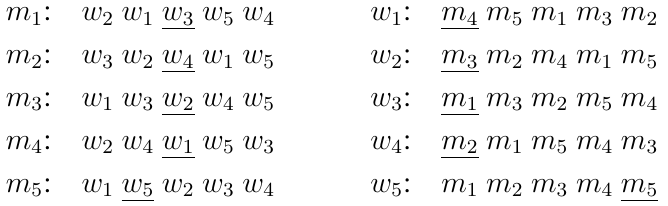
and w to the top in m ’s and 4 5 4